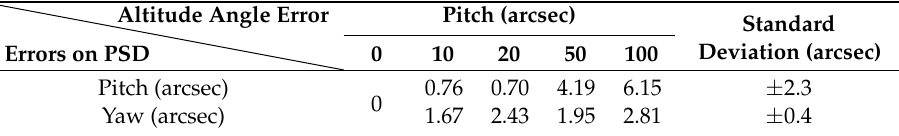
Figure 12. Schematic diagram of the pentaprism setup error detection. Table 3. Uncertainty analysis of the pentaprism setup. Table 3. Uncertainty analysis of the pentaprism setup.